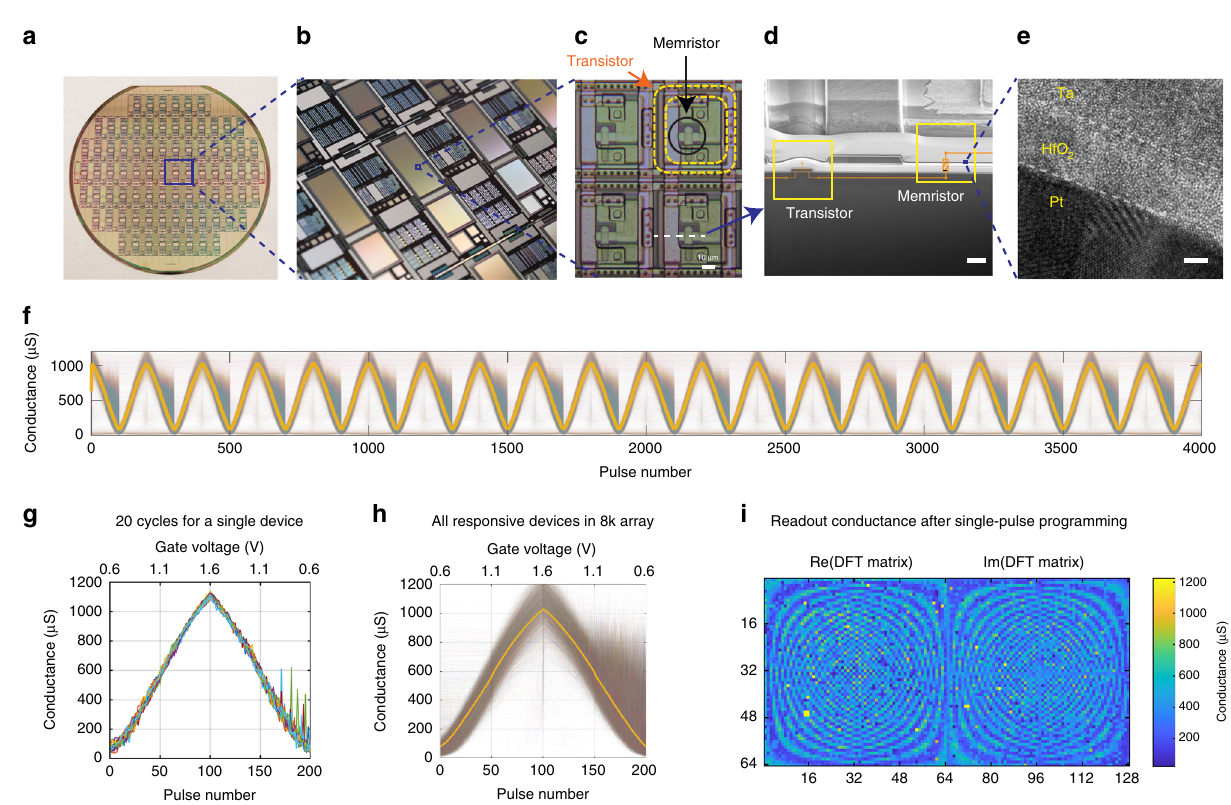
Fig. 1 Memristive platform for in situ learning. a An optical image of a wafer with transistor arrays. b Close-up of chip image showing arrays of various sizes. c Microscope image showing the 1T1R (one transistor one memristor) structure of the cell. Scale bar, 10 µ m. d Cross-sectional scanning electron microscopic image of an individual 1T1R cell, which is cut in a focused ion beam microscope from the dashed line in c . Scale bar, 2 µ m. e Cross-sectional transmission electron microscopic image of the integrated Ta/HfO 2 /Pt memristor. Scale bar, 2 nm. f All responsive devices over 20 potentiation/ depression epochs of 200 pulses each. g Evolution of conductance during 20 cycles of full potentiation and depression for a single cell with 200 pulses per cycle, showing low cycle-to-cycle variability. More results are shown in Supplementary Fig. 1. h Evolution of conductance over one 200-pulse cycle of full potentiation and depression for all responsive devices in the array, with median conductance indicated by the yellow line. i Conductance of a 128 × 64 array after single-pulse conductance writing of the discrete Fourier transform matrix. Several stuck devices are visible (in